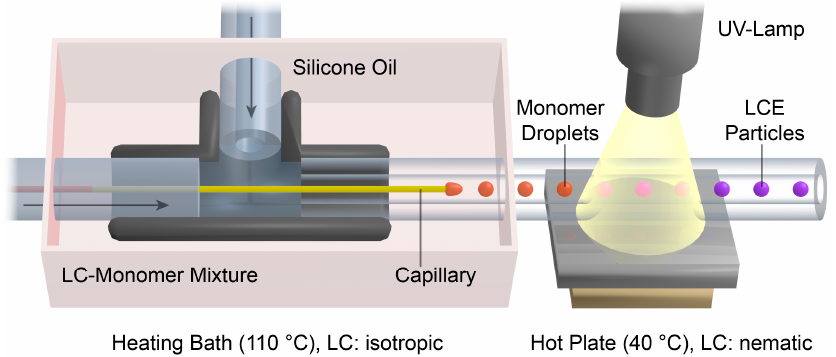
Figure 1. Schematic illustration of the co-flow microfluidic setup. The capillary displayed in yellow is connected to the PTFE (polytetrafluoroethylene) tube on the left side of the T-junction and provides the liquid crystalline monomer mixture. The continuous silicone oil phase is injected into the T-junction via the PTFE tube on the upper side. Monomer droplets are formed at the capillary’s tip and further polymerized by transportation through UV-light. (UV: ultraviolet, LC: liquid crystal, LCE: liquid crystalline elastomer).